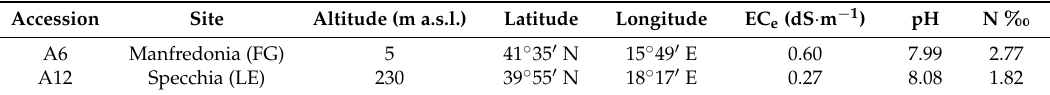
Table 1. Altitude, latitude, longitude, electrical conductivity (EC e ), pH, and total N of the soil of sites where the two accessions (A6 and A12) were collected.